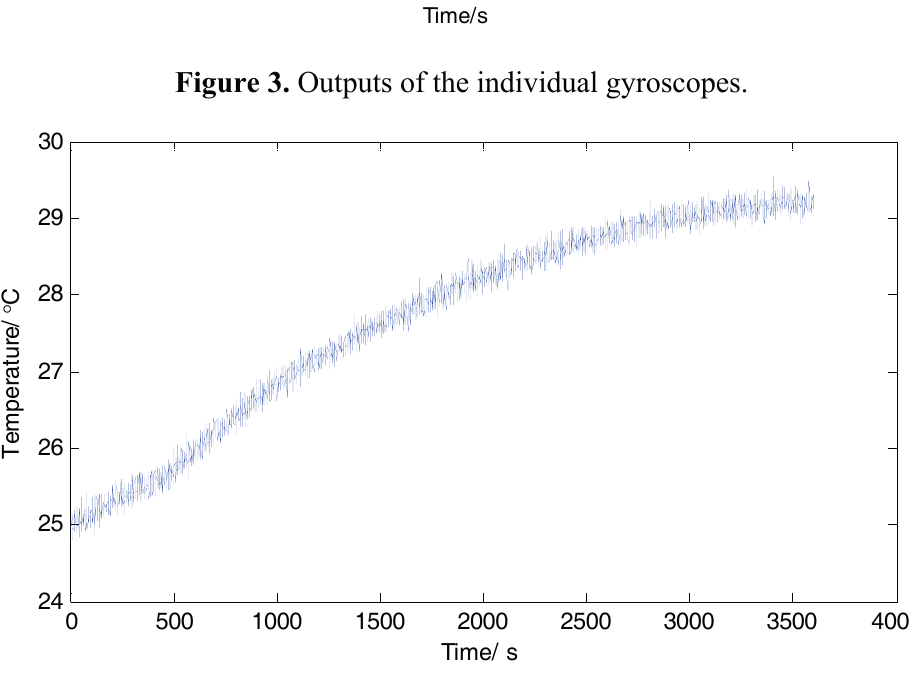
Figure 4. Internal temperature of